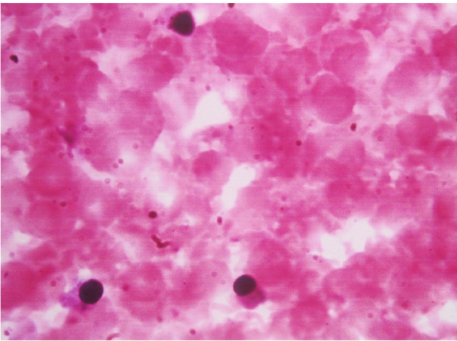
Figure 1: Photomicrograph of nucleated red blood cells in cord blood of a